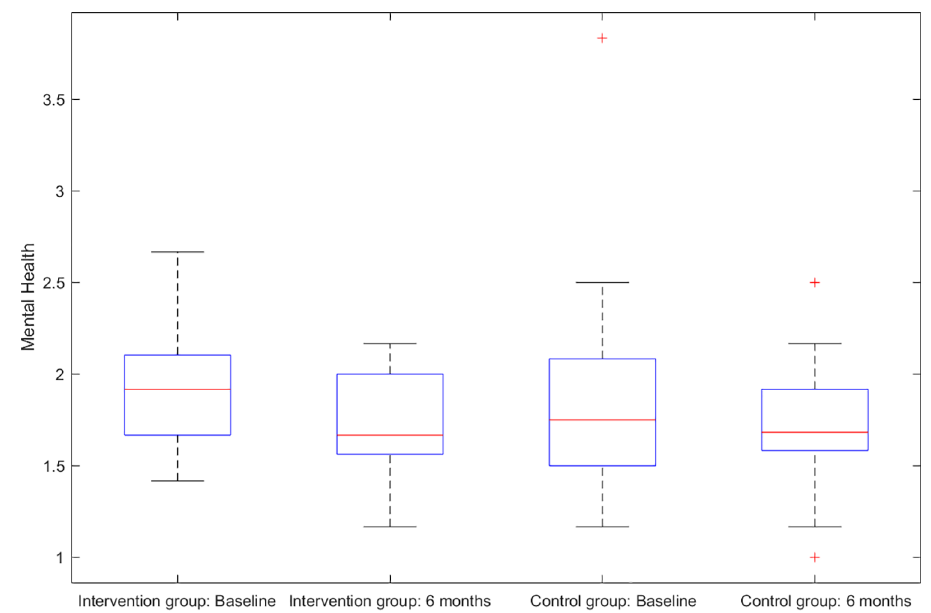
Fig 6. Boxplots of mental health for treatment and control groups at baseline and 6-month visits.